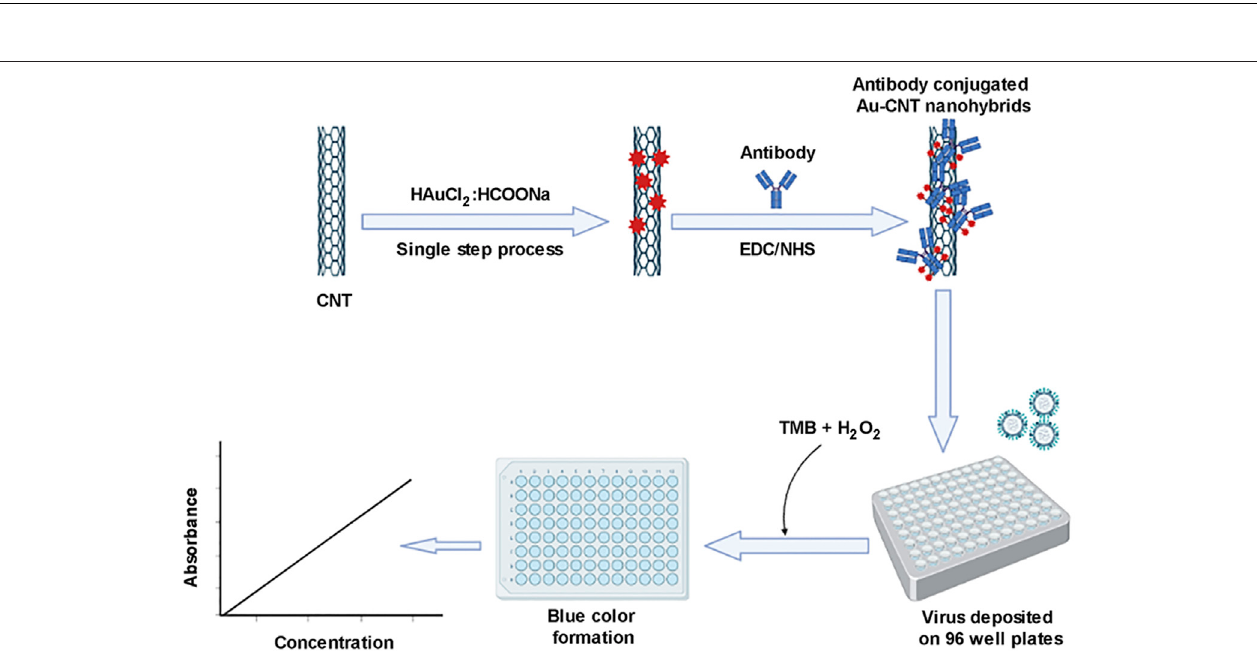
FIGURE 4 | In fl uenza virus detection by carbon nanotube biosensor.